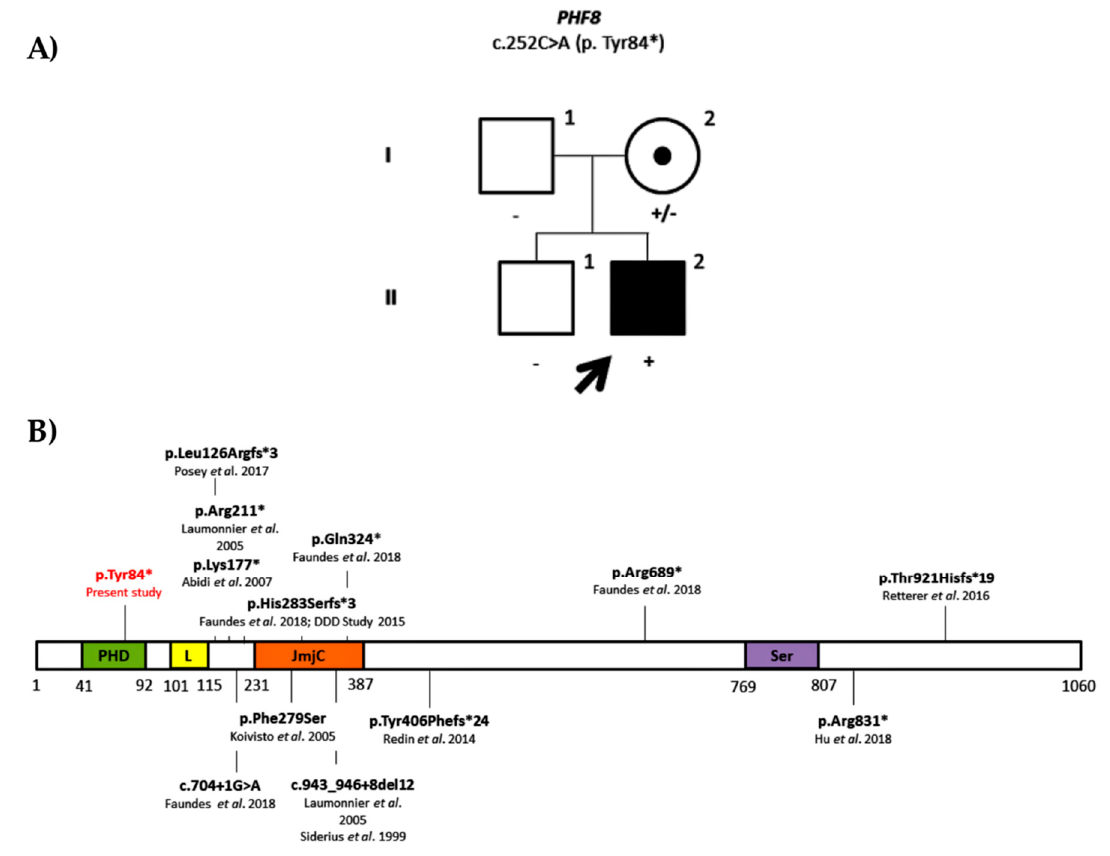
Figure 1. ( A ) Family pedigree of the ID0707 proband. Segregation analysis of the nonsense variant in PHF8 gene (NM_001184896.1: c.252C > A; p. Tyr84*). ( B ) Histone lysine demethylase PHF8 protein. Protein domains are shown in color: In green, plant homeodomain (PHD) finger domain; in yellow, linker region (L); in orange, jumonji-C (JmjC) domain; and in purple, serine-rich domain (Ser). All the mutations identified to date are also shown with the respective references. The present variant is shown in red.